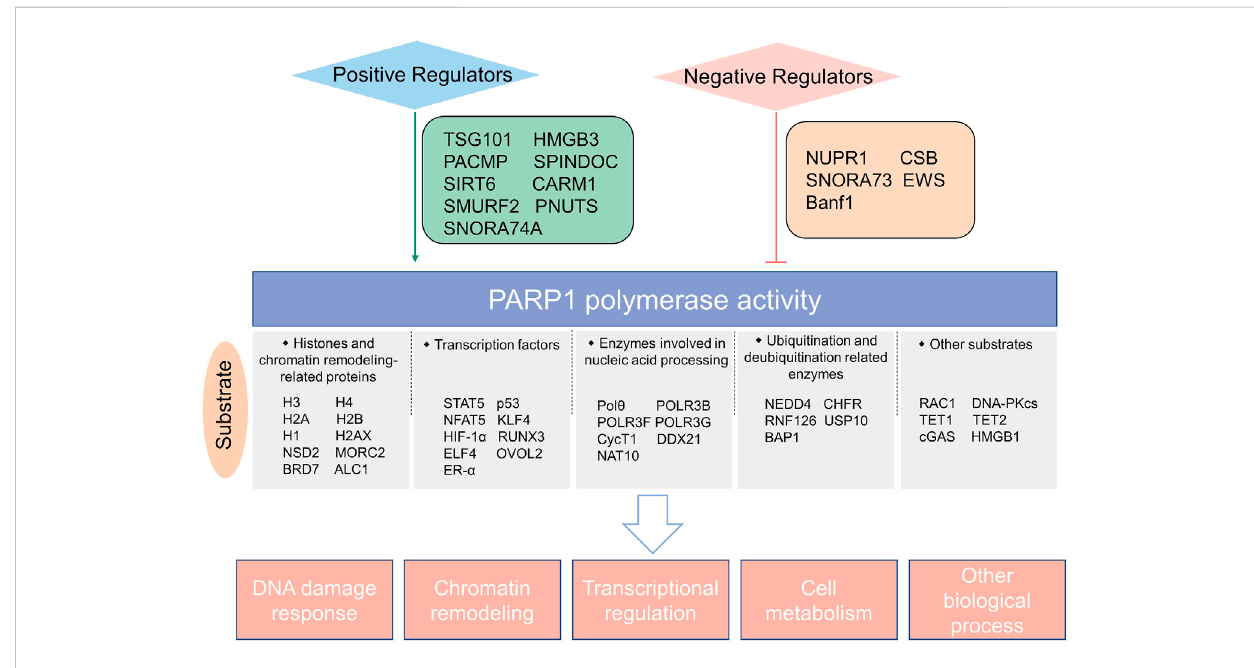
FIGURE 4 Schematic summary of PARP1 catalytic substrates and regulators of PARP1 enzymatic activity identi fi ed in the last 3